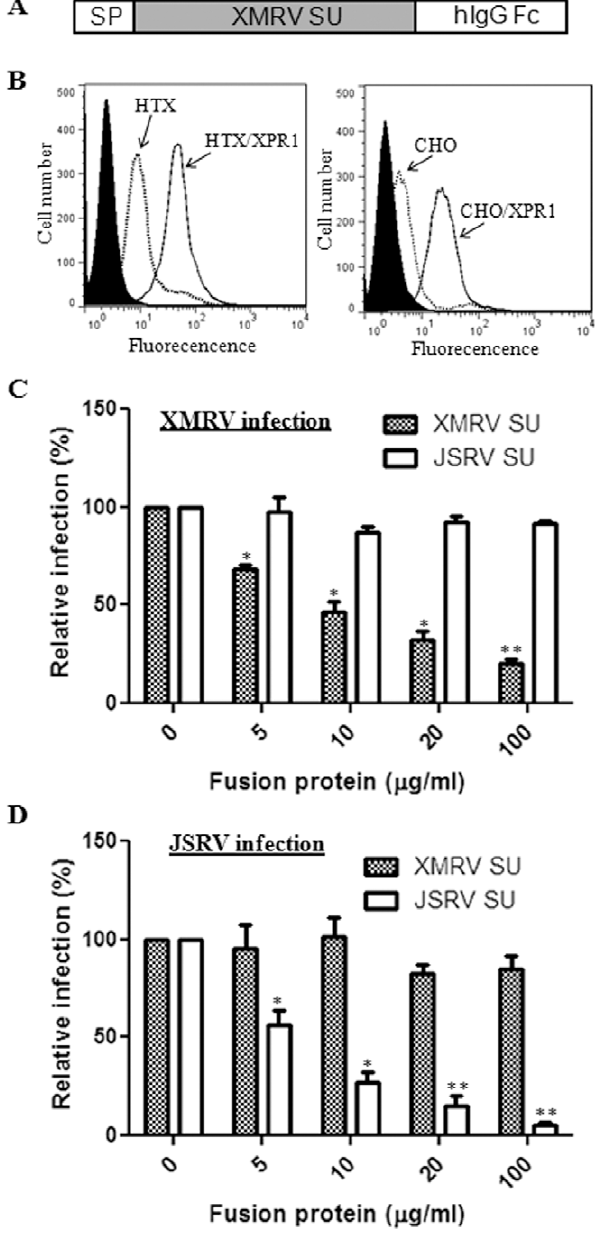
Figure 2. Soluble XMRV SU binds to cells expressing the viral entry receptor, XPR1, and blocks XMRV pseudovirion infection. (A) Schematic representation of XMRV SU-human immunoglobulin (hIgG) Fc fusion protein. SP: signal peptide. (B) Indicated cell lines were incubated with 5 m g of XMRV SU-hIgG Fc for 4 h and binding was measured using anti-human IgG FITC and flow cytometry. Filled: HTX or CHO cells stained with a FITC-labeled secondary antibody only (HTX/XPR1 or CHO/XPR1 cells gave a similar background signal which was not overlaid); broken line: parental HTX or CHO cells stained with XMRV SU plus secondary antibody; black line: HTX/XPR1 or CHO/XPR1 cells stained with both XMRV SU and secondary antibody. Representative experiments are shown (n=5). (C, D) HTX cells were pre-bound withindicated amountsof solubleXMRVor JSRV SU for1 h at 4 u C and infected withMoMLVpseudotypes encoding alkaline phosphatase (AP) and bearing XMRV Env (C) or JSRV Env (D) for 6 h before inactivation of remaining virions using citrate buffer. AP foci were counted 72 h post-infection and values were normalized toinfection in theabsence of soluble protein set to 100%. Shown are the averages of 3 independent experiments 6 S.D. * indicates p , 0.05; ** indicates p ,